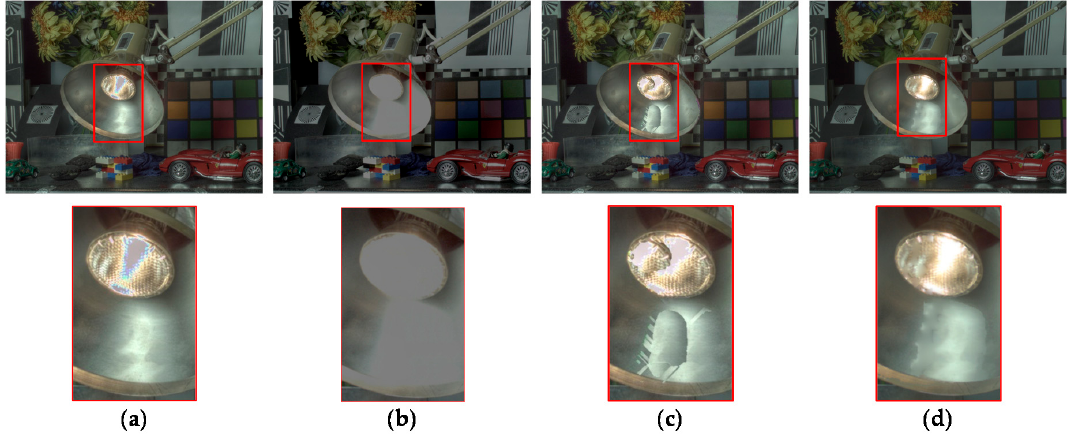
Figure 18. Resultant LDR images for the IIS Jumble image: ( a ) reference image; ( b ) Lin and coworkers’ method [14]; ( c ) Batz and coworkers’ method [16]; and ( d ) proposed method.